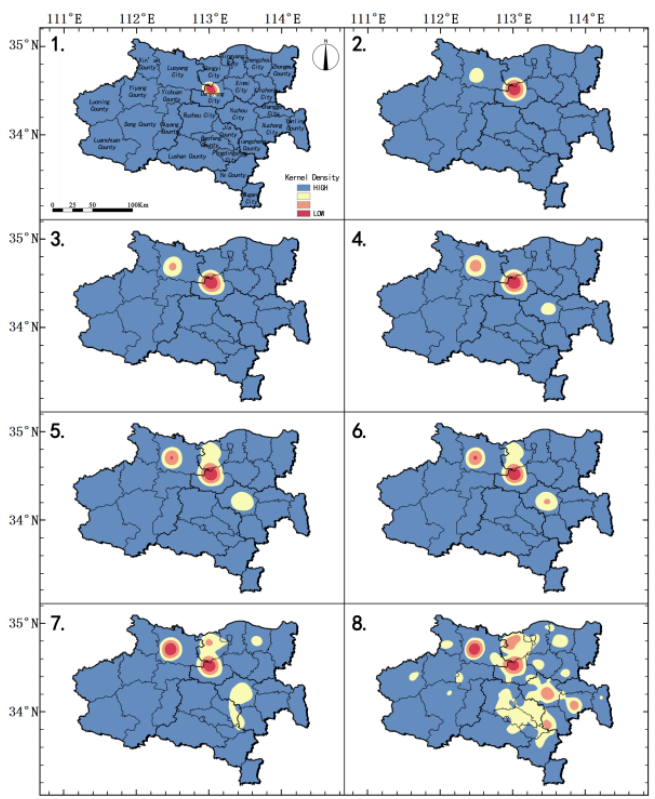
Figure 18. Cumulative quantity changes in historical buildings in the Songshan region by each